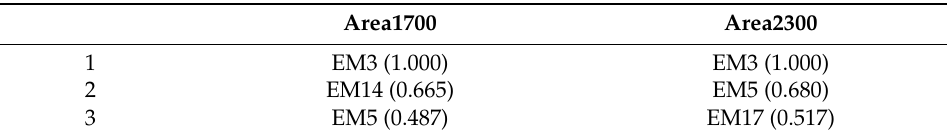
Table 4. Endmembers sorted according to their Area1700 index normalized between 0 and 1 (values in parenthesis). Normalized values of Area2300 are also shown.